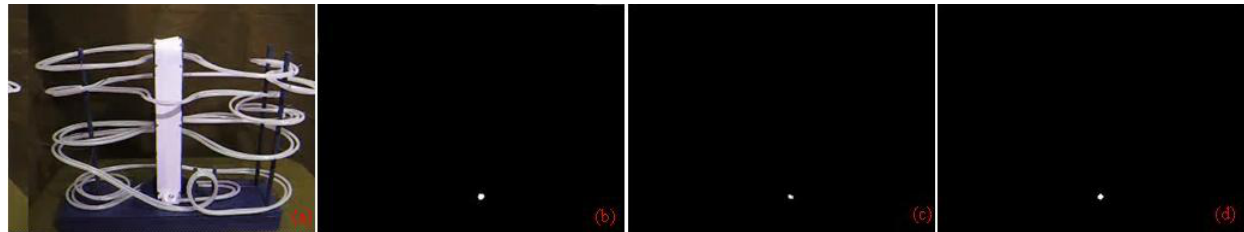
Figure 10. Simulation results for the grey world algorithm. ( a ) Input ( b ) Ground truth ( c ) Method: Renno et al . ( d ) Zulkifley et al